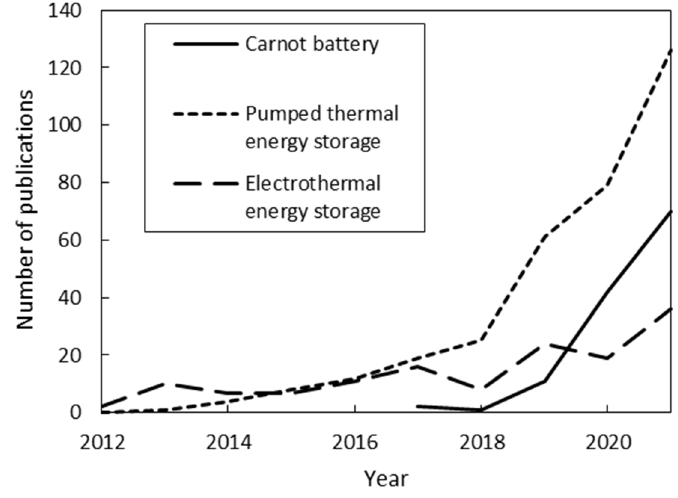
Figure 4. Bibliographic study on a yearly number of scientific works with main CB keywords.